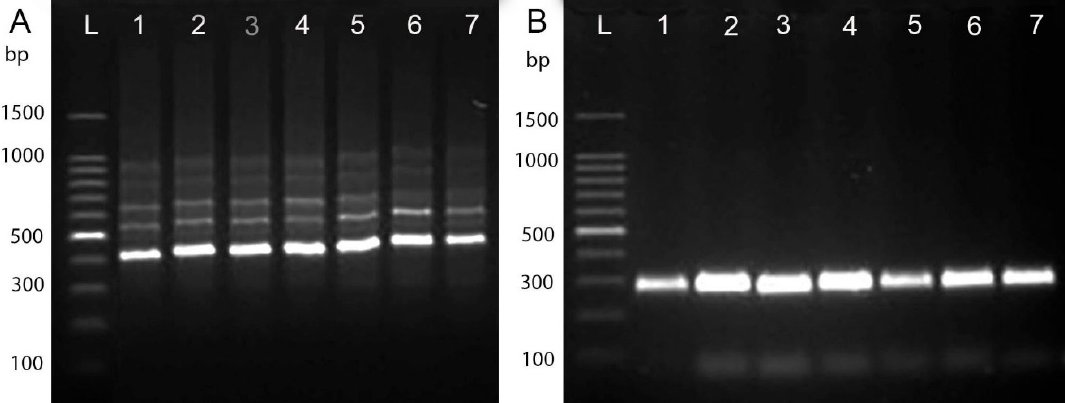
Figure 3. Examples of DNA profiles amplified from micropropagated Hancornia speciosa plantlets by using ISSR primer UBC 851 ( A ) and SSR primer HS 08 ( B ). L: 100 bp DNA ladder from Invitrogen. 1: ISSR ( A ) and SSR ( B ) profiles for the donor plant A5, from Site 2 (Caçu). Lanes 2 to 7 represent tissue culture recovered from plants during six subcultures.